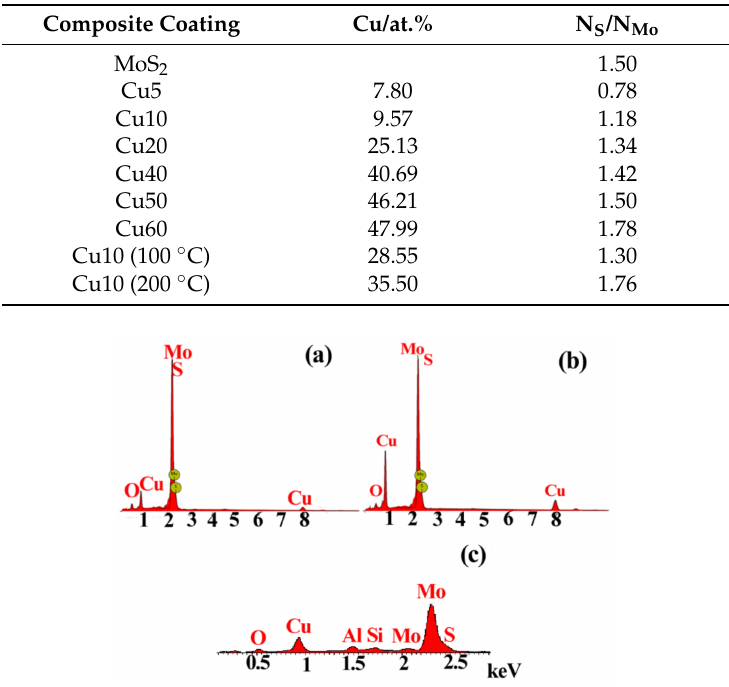
Table 2. Quantitative results of Cu/MoS 2 coatings elemental analysis, determined through EDS.